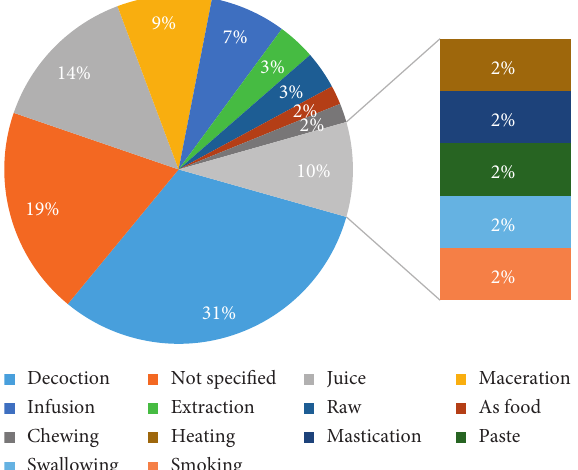
Figure 2: Frequencies of formulations.